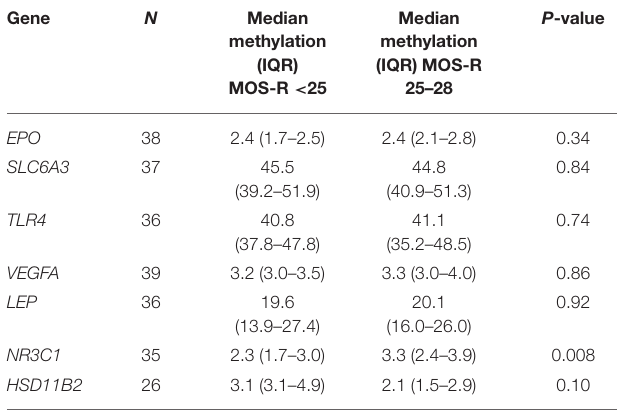
TABLE 2 | Participant characteristics ( N = 43). TABLE 3 | Average methylation of the selected